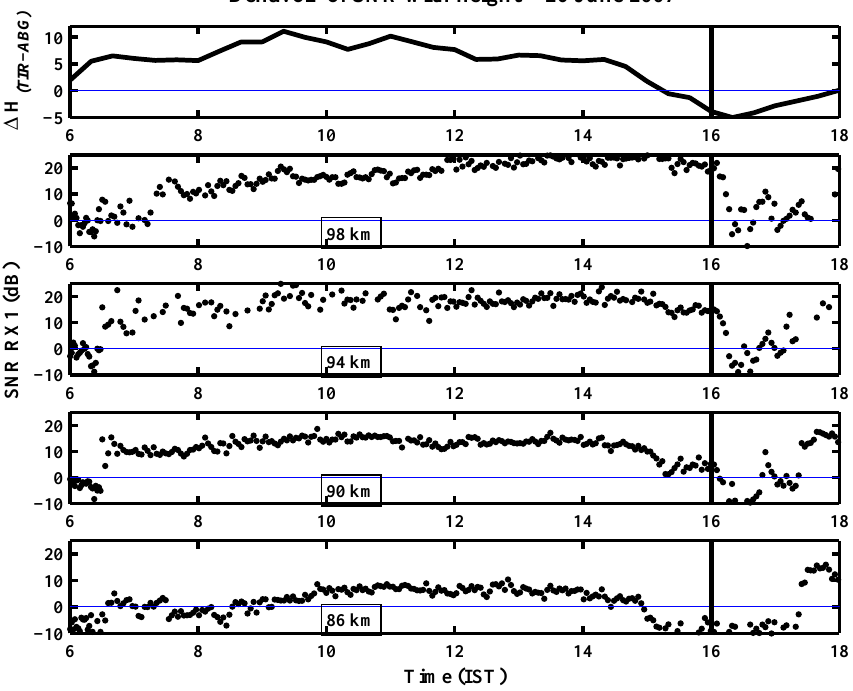
Fig. 2a. Temporal variation of electrojet strength (top panel) given by [ 1H TIR − 1H ABG ] and SNR for 86, 90, 94, and 98km on 26 June 2007 (four panels from the bottom).